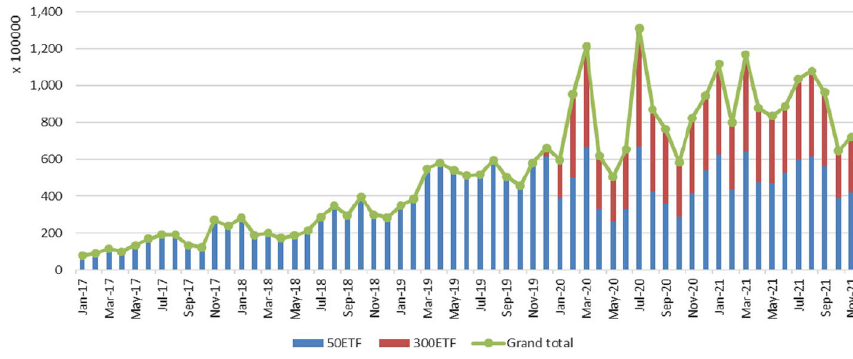
Fig. 1 Monthly trading volume of index options in